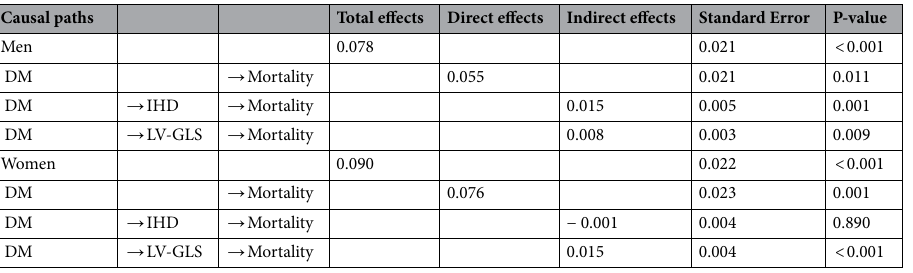
Table 4. Coefficients and standard errors of the structural equation path models of direct and indirect effects of DM for mortality. SEM models were constructed to identify the direct and indirect effects of DM on the mortality. 5-year death data was used for mortality. DM = diabetes mellitus; IHD = ischemic heart disease; LV-GLS = left ventricular global longitudinal strain; SEM = structural equation